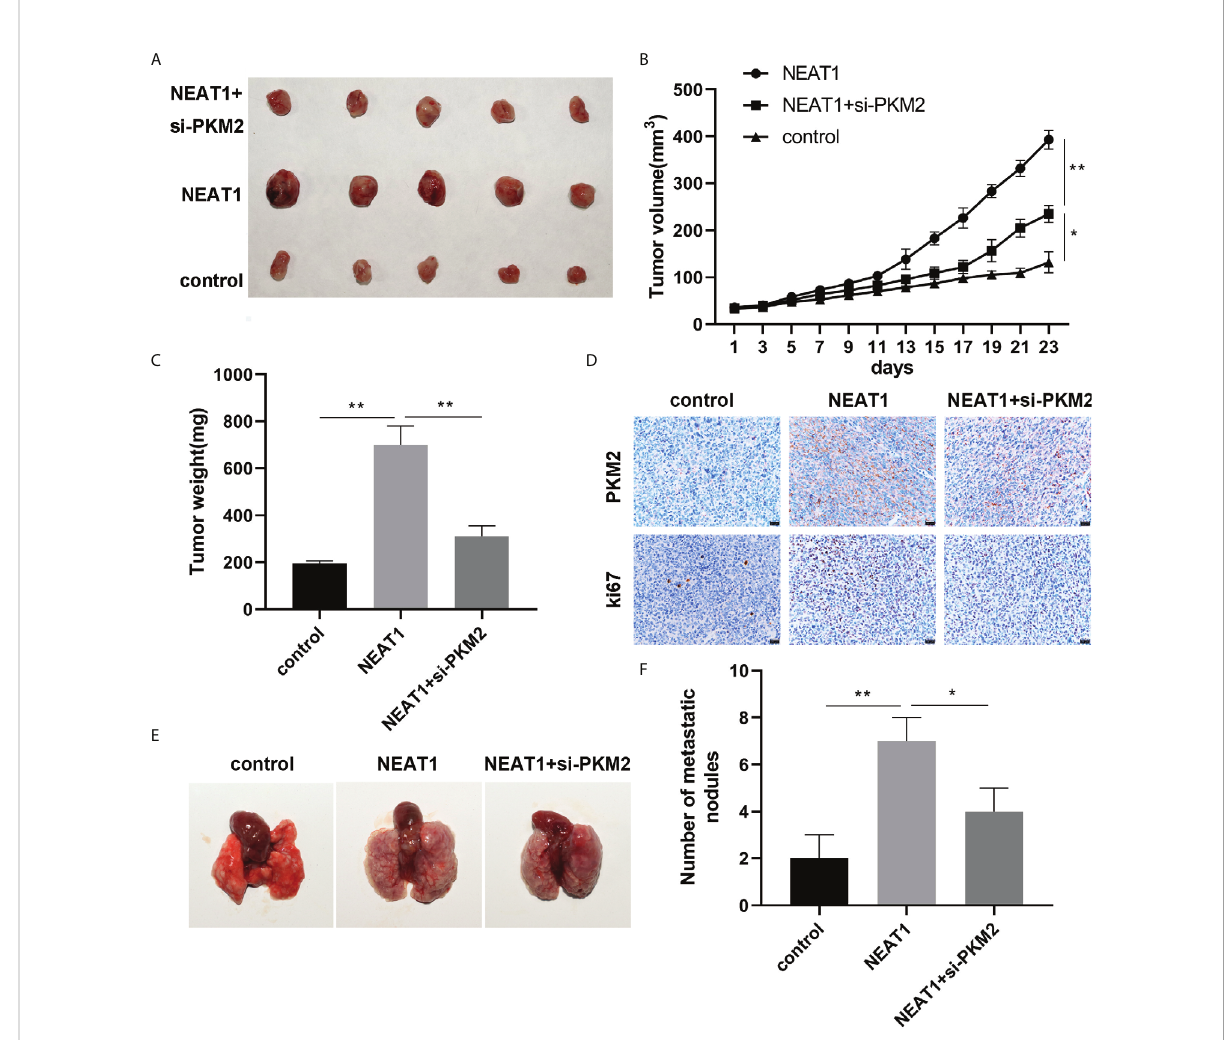
FIGURE 5 In-vivo experiments were conducted to investigate the effects of NEAT1 and PKM2 on the growth of HCC. (A) A picture of the tumor is shown. (B) The curve of tumor growth. (C) The weight of the tumors was assessed. (D) Histochemistry was used to detect the expression of Ki67 and PKM2 in the tumor tissues, proving the conclusion of the cell part. (E, F) Lung metastasis was analyzed. * indicates P < 0.05; ** indicates P <